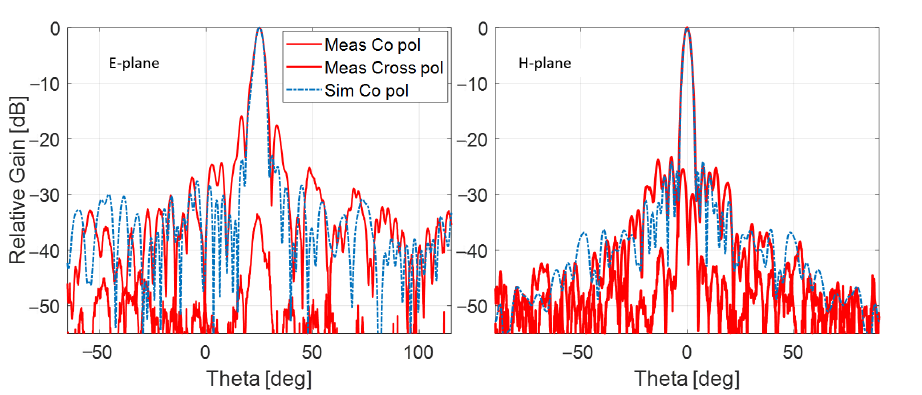
Figure 10. Radiation patterns in the E ( left ) and H ( right ) planes at 31